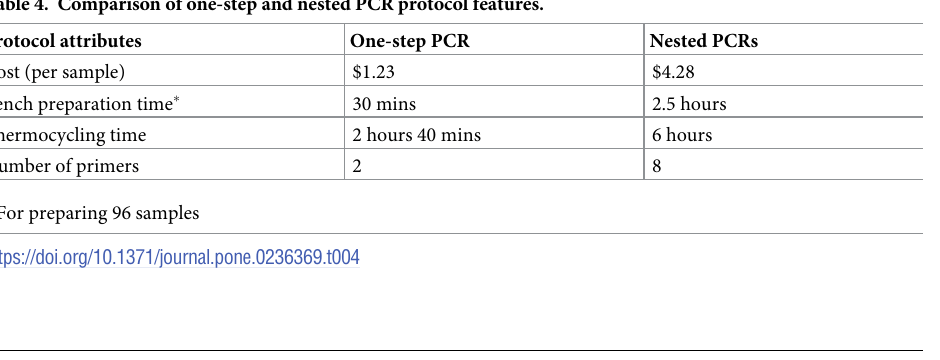
Table 4 outlines a comparison of the one-step PCR and nested PCR protocols. The one-step PCR is 71.3% less expensive, and faster both in terms of hands on preparation time (80.0% less time) and thermocycling time (55.6% less time).